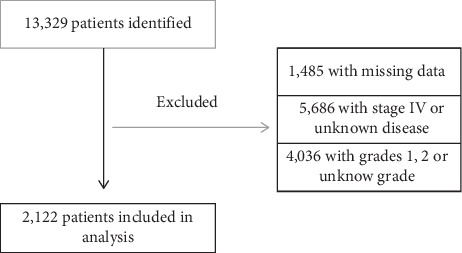
Study cohort inclusion criteria.